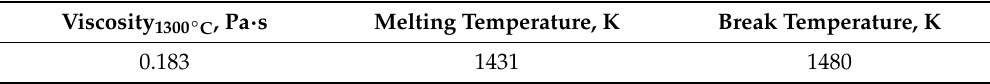
Table 2. Physical property of the mold